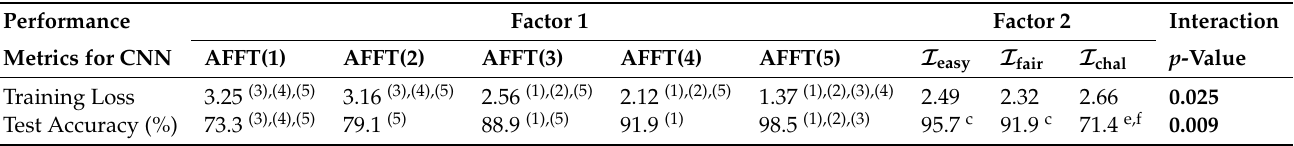
Table 3. Two metrics of convolutional neural network (CNN) performance. Value represents the mean for the five levels of data augmentation by AAFT (Factor 1) and the three levels of manipulation for the recognizability of input image features (Factor 2), and p -values for interaction effect. Superscripts represent significant differences from the other main effects conditions resulting from Bonferroni adjusted pairwise